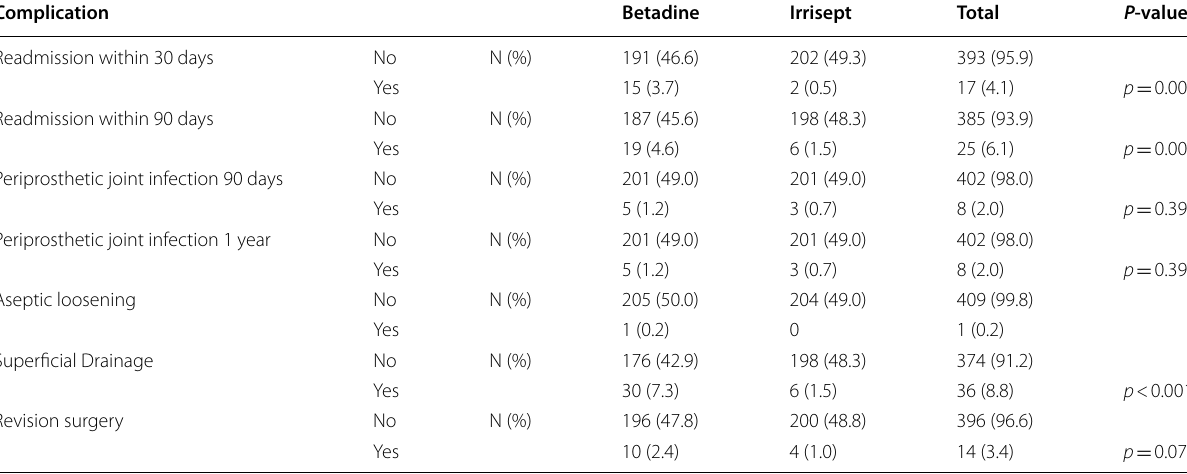
Table 2 Complications for betadine versus CHG lavage: all total joint arthroplasty Complication